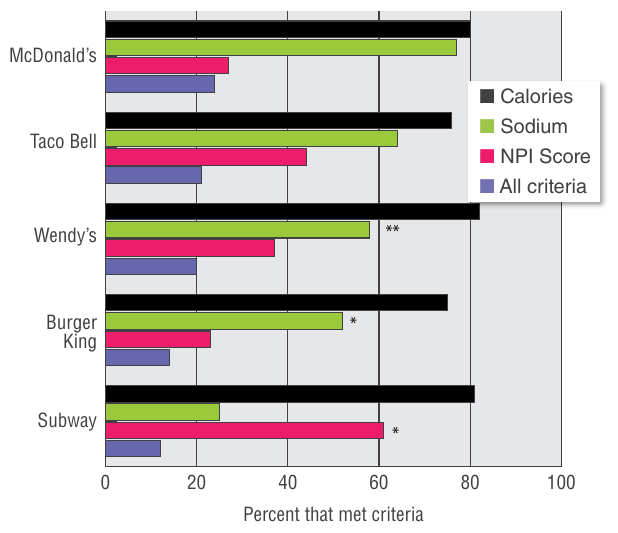
Figure 4. Percent of menu items by restaurant that met nutrition